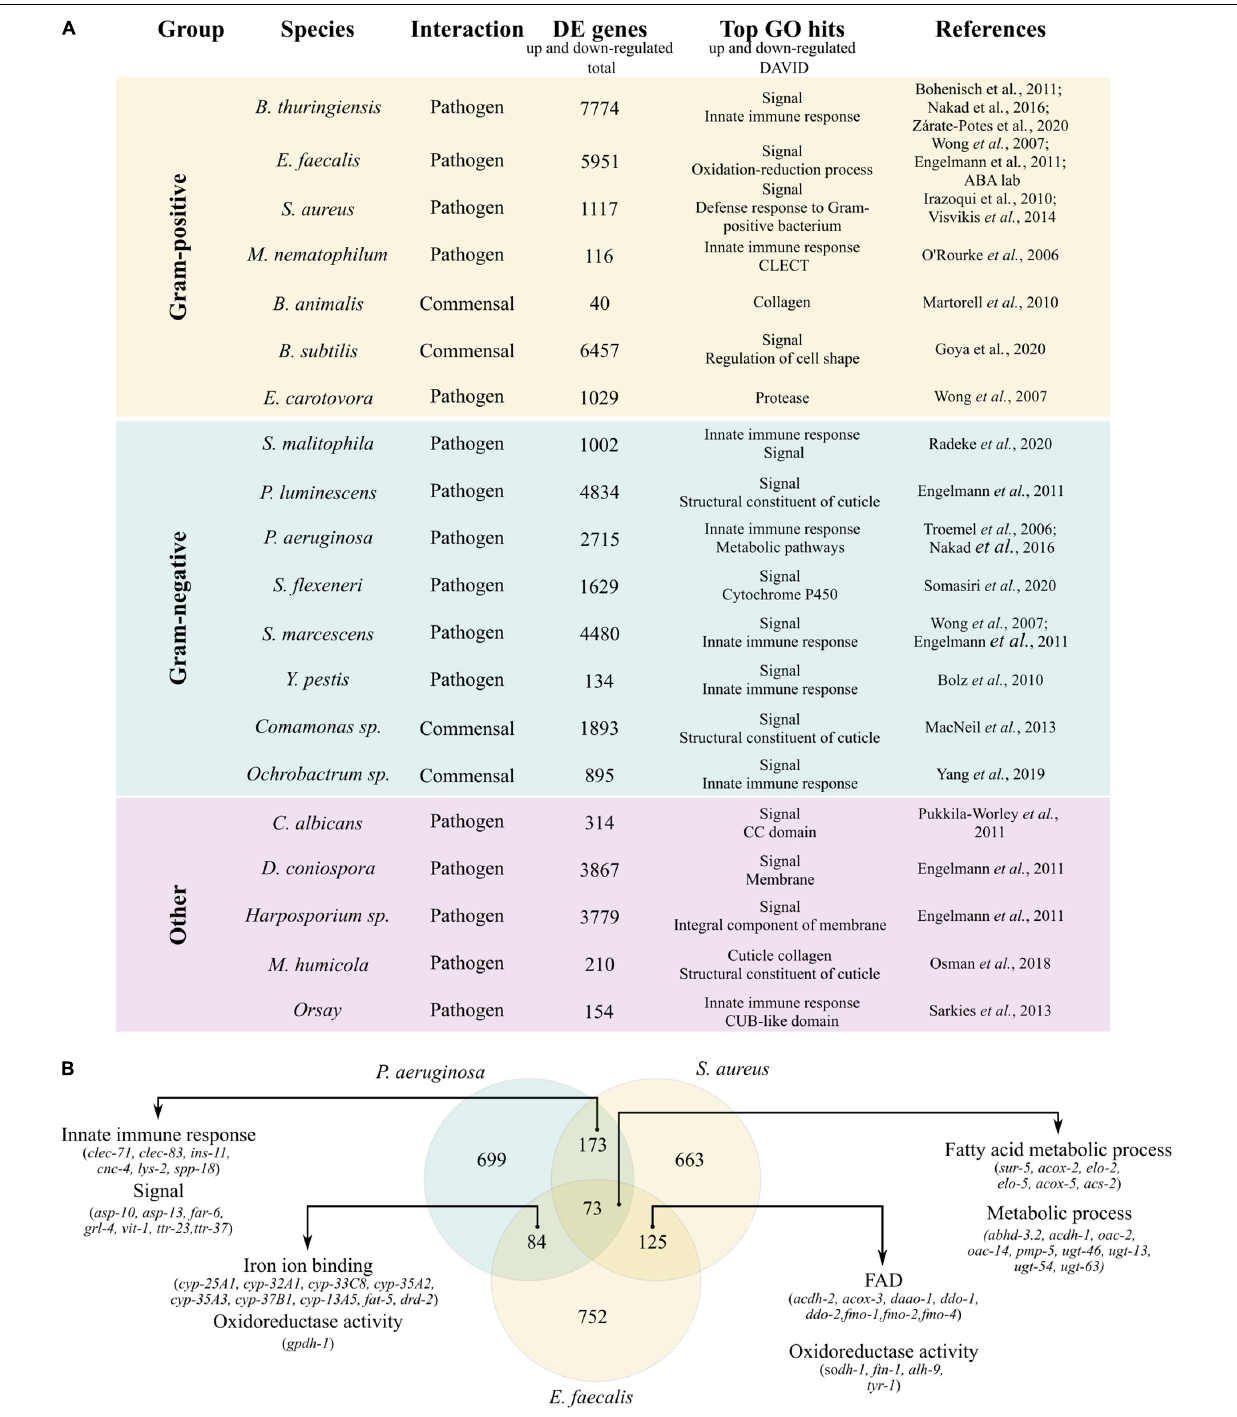
Frontiers in Microbiology |